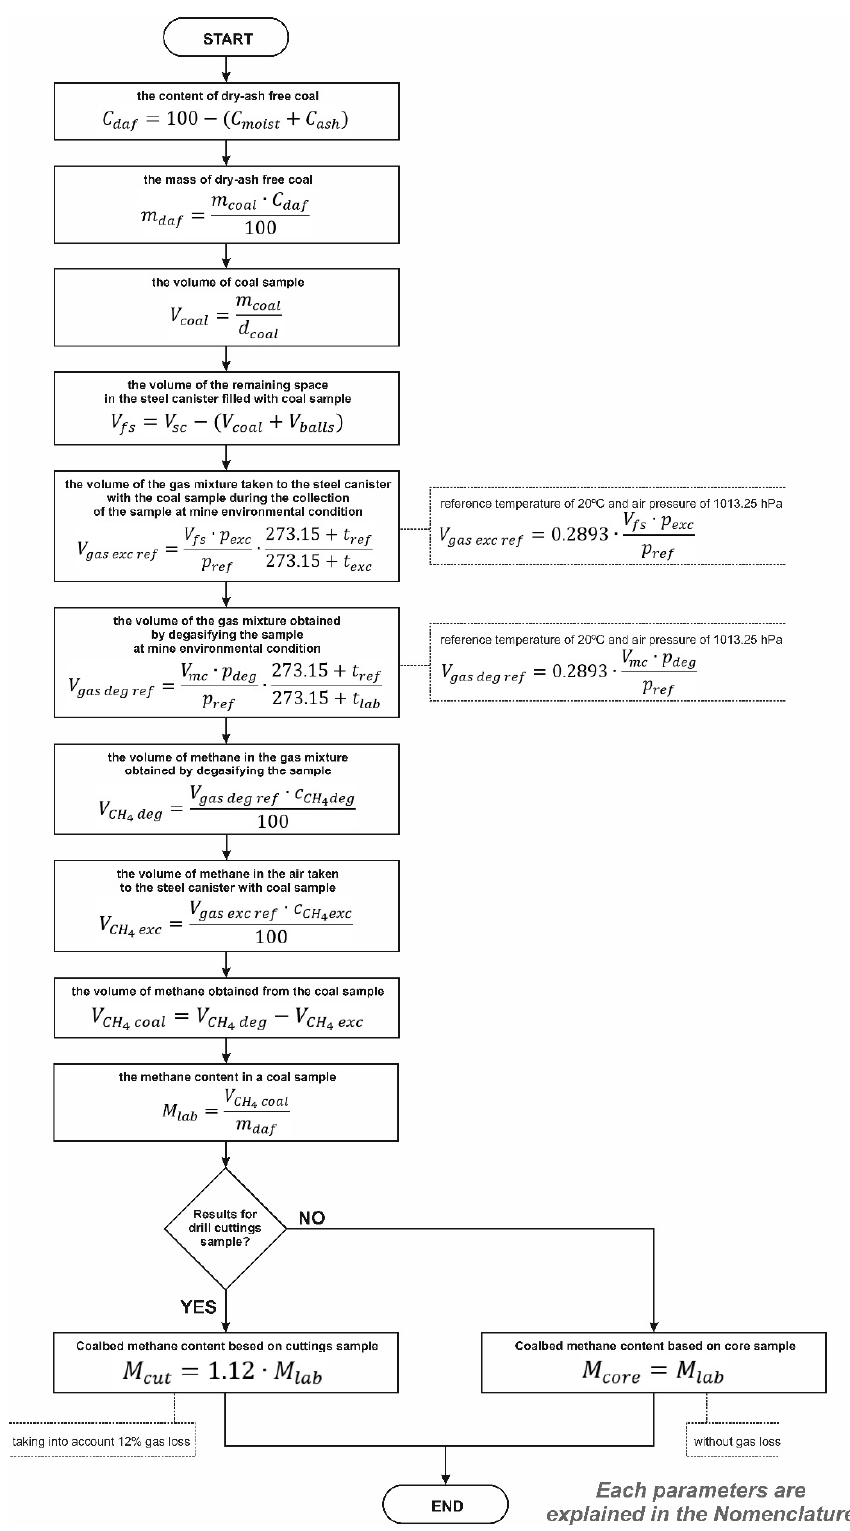
Figure 4. Algorithm for calculating methane content of coal for the drill cutting and core samples.